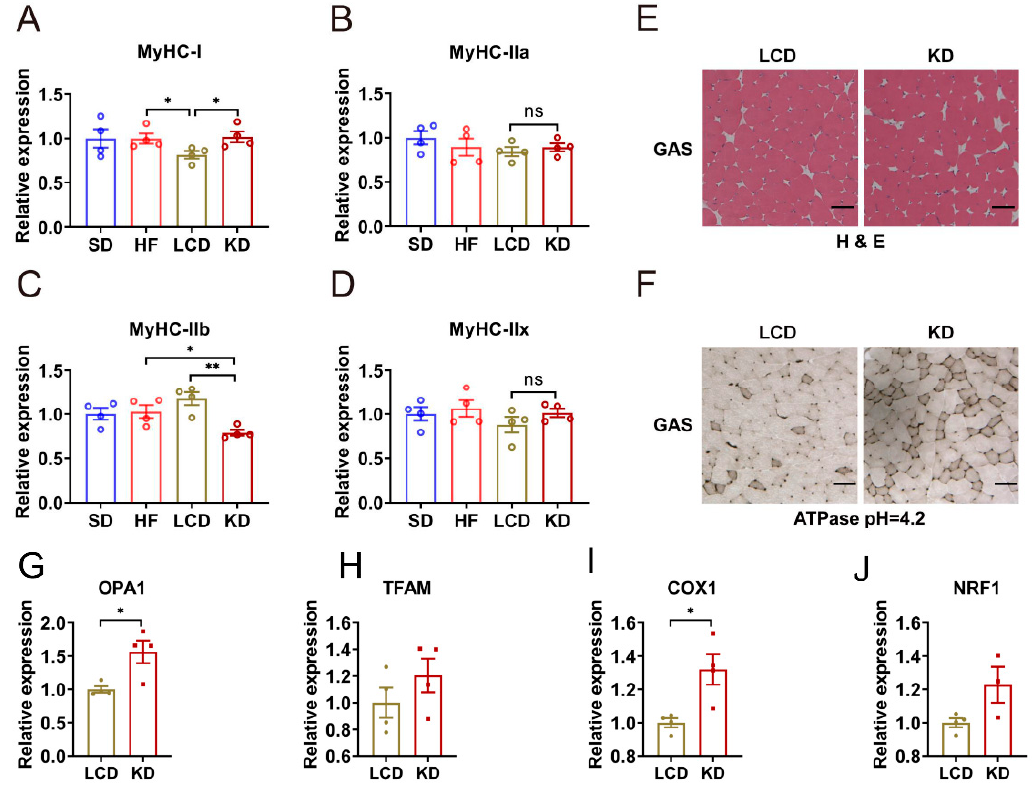
Figure 2. Ketogenic diet promoted the percentage of type I fibers. ( A – D ) mRNA levels of ( A ) MyHC-I , ( B ) MyHC-IIa , ( C ) MyHC-Iib, and ( D ) MyHC-IIx in the GAS muscle. ( E ) Representative images of H&E staining in the GAS muscle of the LCD group or ketogenic diet group. ( F ) Representative images of ATPase staining in the GAS muscle of the LCD group or ketogenic diet group. ( G – J ) mRNA levels of ( G ) OPA1 , ( H ) TFAM , ( I ) COX1, and ( J ) NRF1 in the GAS muscle. Means ± SEM are shown. * p < 0.05, ** p < 0.01 di ff erences between groups, ns: no signi fi cance.